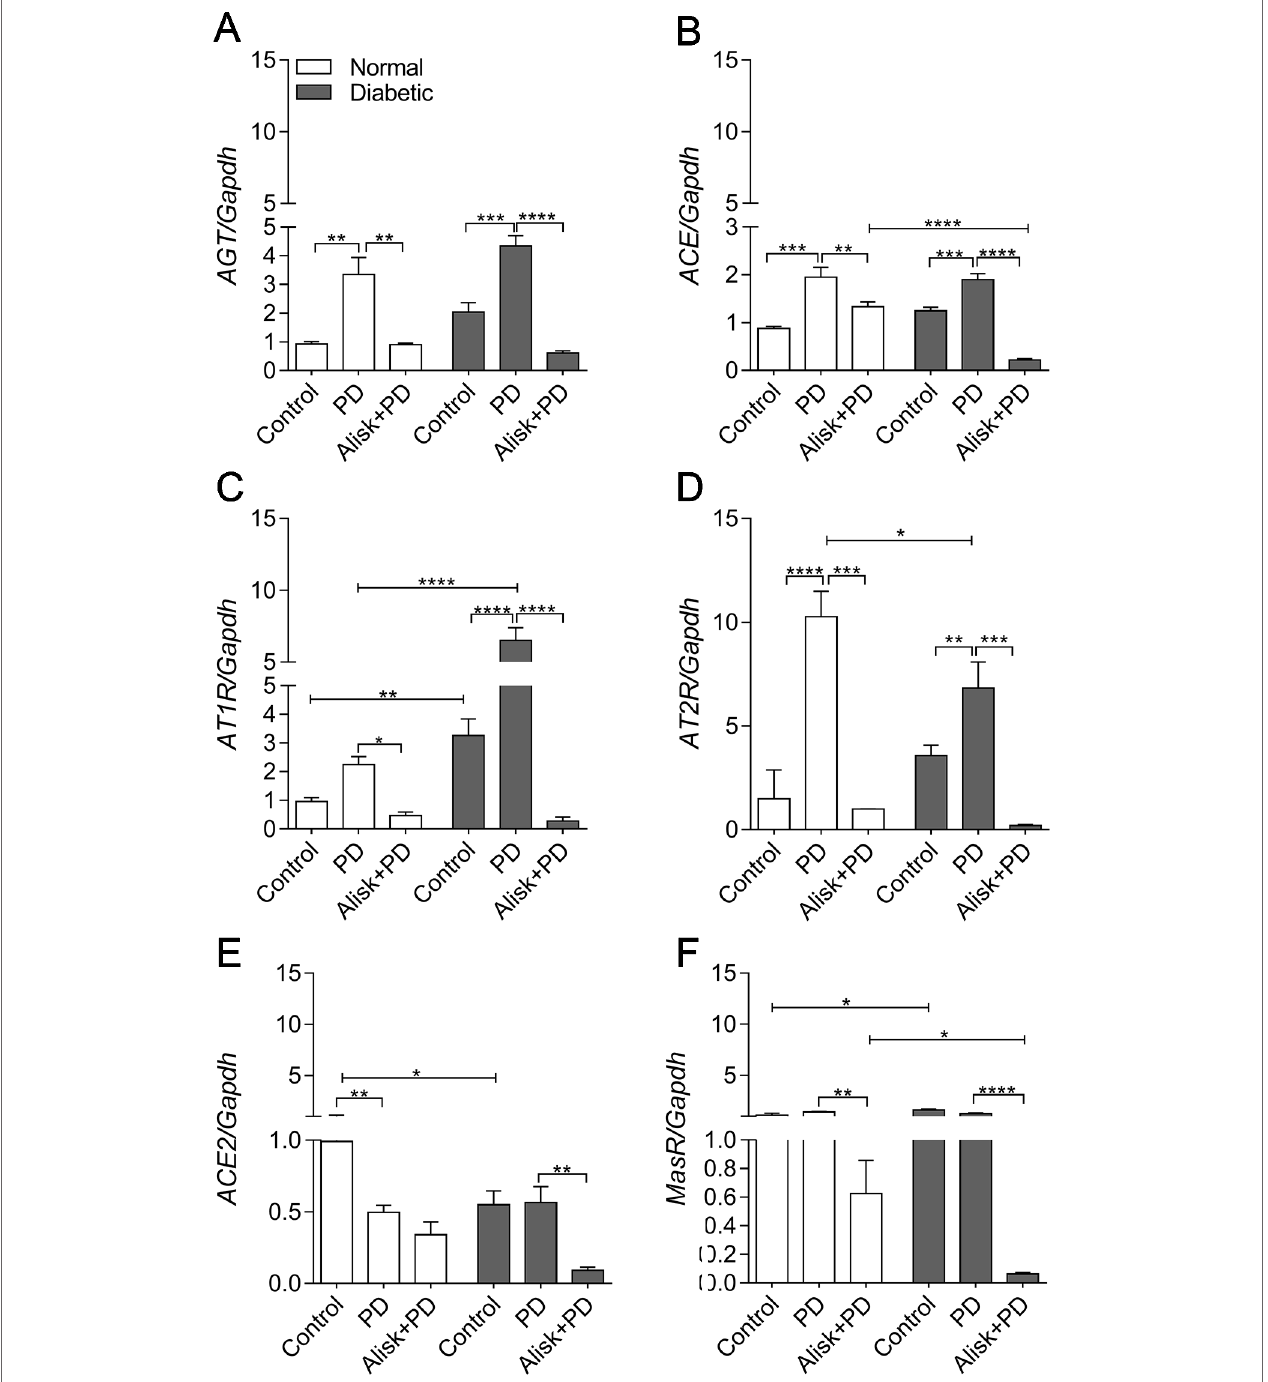
FIGURE 3 | AGT , ACE , AT1R , AT2R , ACE2 , and MasR gene expression of gingival tissue from normal and diabetic mice 14 days after PD. (A) AGT , (B) ACE , (C) AT1R , (D) AT2R , (E) ACE2 , and (F) MasR in gingival tissue of control, normal mice with PD (PD), normal mice with PD treated with aliskiren (Alisk + PD), control, diabetic mice with PD (PD), diabetic mice with PD treated with aliskiren (Alisk + PD) by real-time RT-PCR. Results express mean ± SEM, normalized by fold change. Significant values are represented by *p < 0.001, **p < 0.05, ***p < 0.005, and ****p < 0.0001 (Control vs. PD, PD vs. Alisk+ PD, PD vs. PD, PD+Alisk vs.